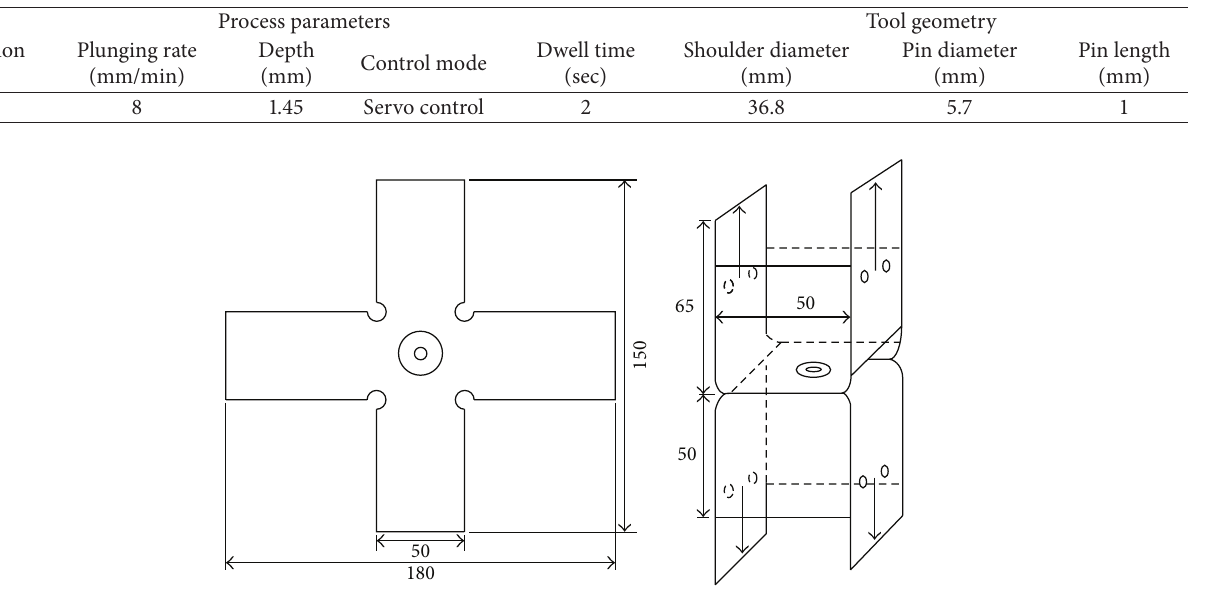
Table 2: Friction stir spot welding parameters and tool geometry used in the experiments.